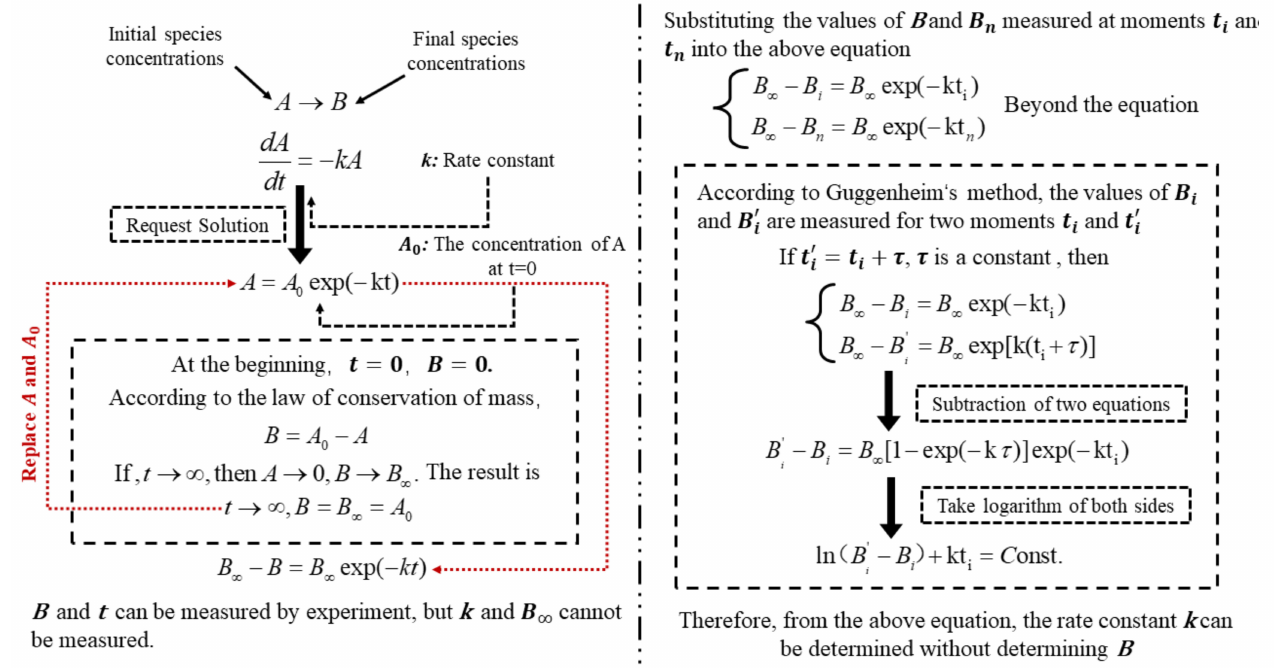
Figure 2. Determine the decay rate constant according to Guggenheim’s method.